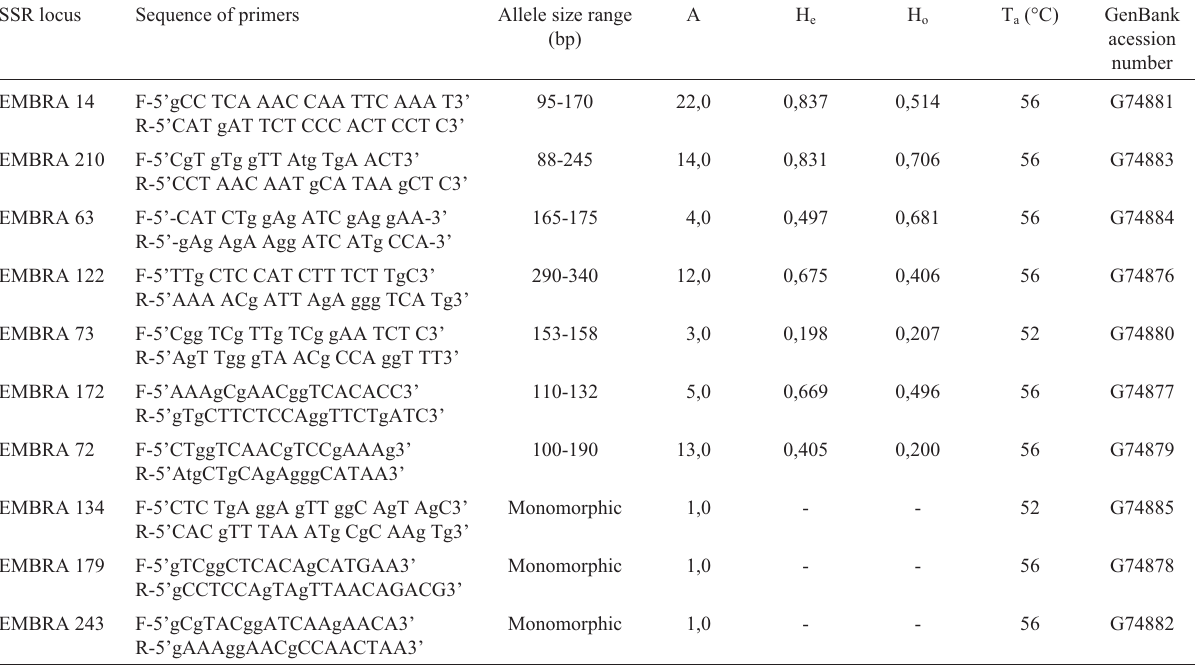
Table 2 - Sequence of primer pairs developed for Eucalyptus* that amplified microsatellite loci in Eugenia dysenterica with allele size range, number of alleles per locus (A), expected heterozigosity (H e ), observed heterozigosity (H o ) and annealing temperature (T a ). SSR locus Sequence of primers Allele size range